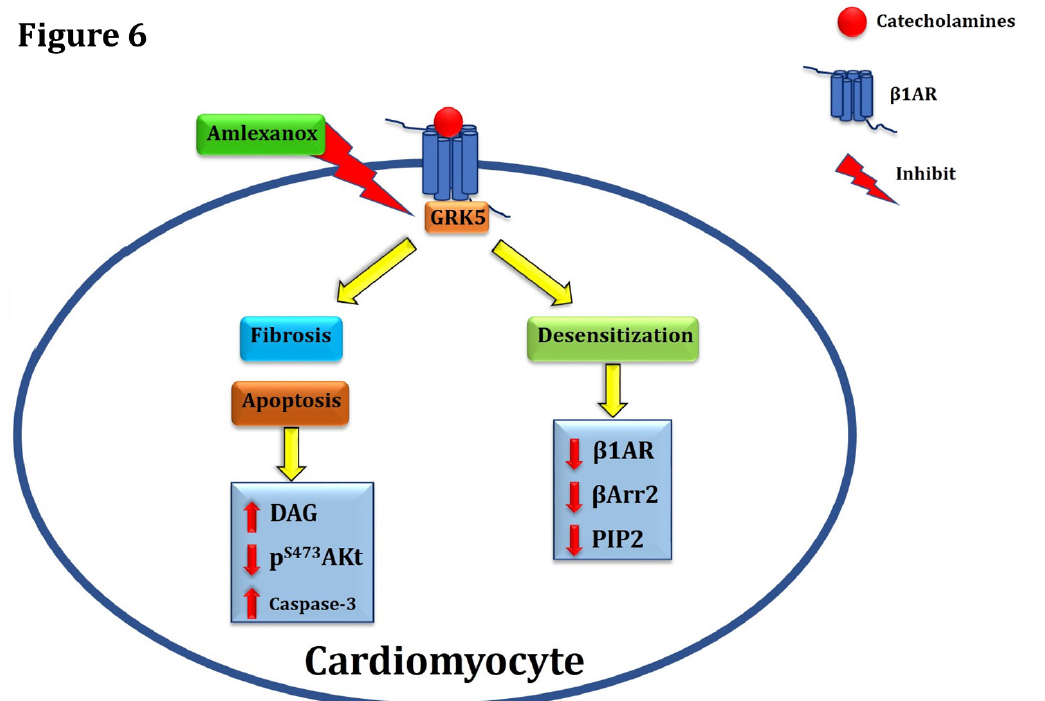
FIGURE 6 - Possible mechanisms for the cardioprotective effect of